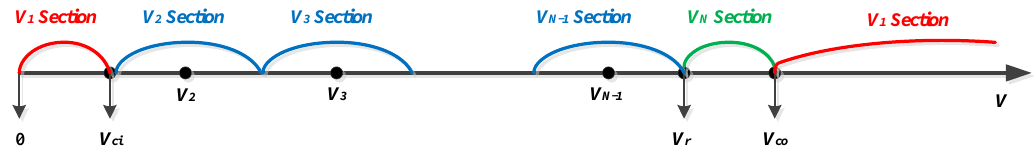
Figure 1. Sectionalized wind speed points in selecting process.